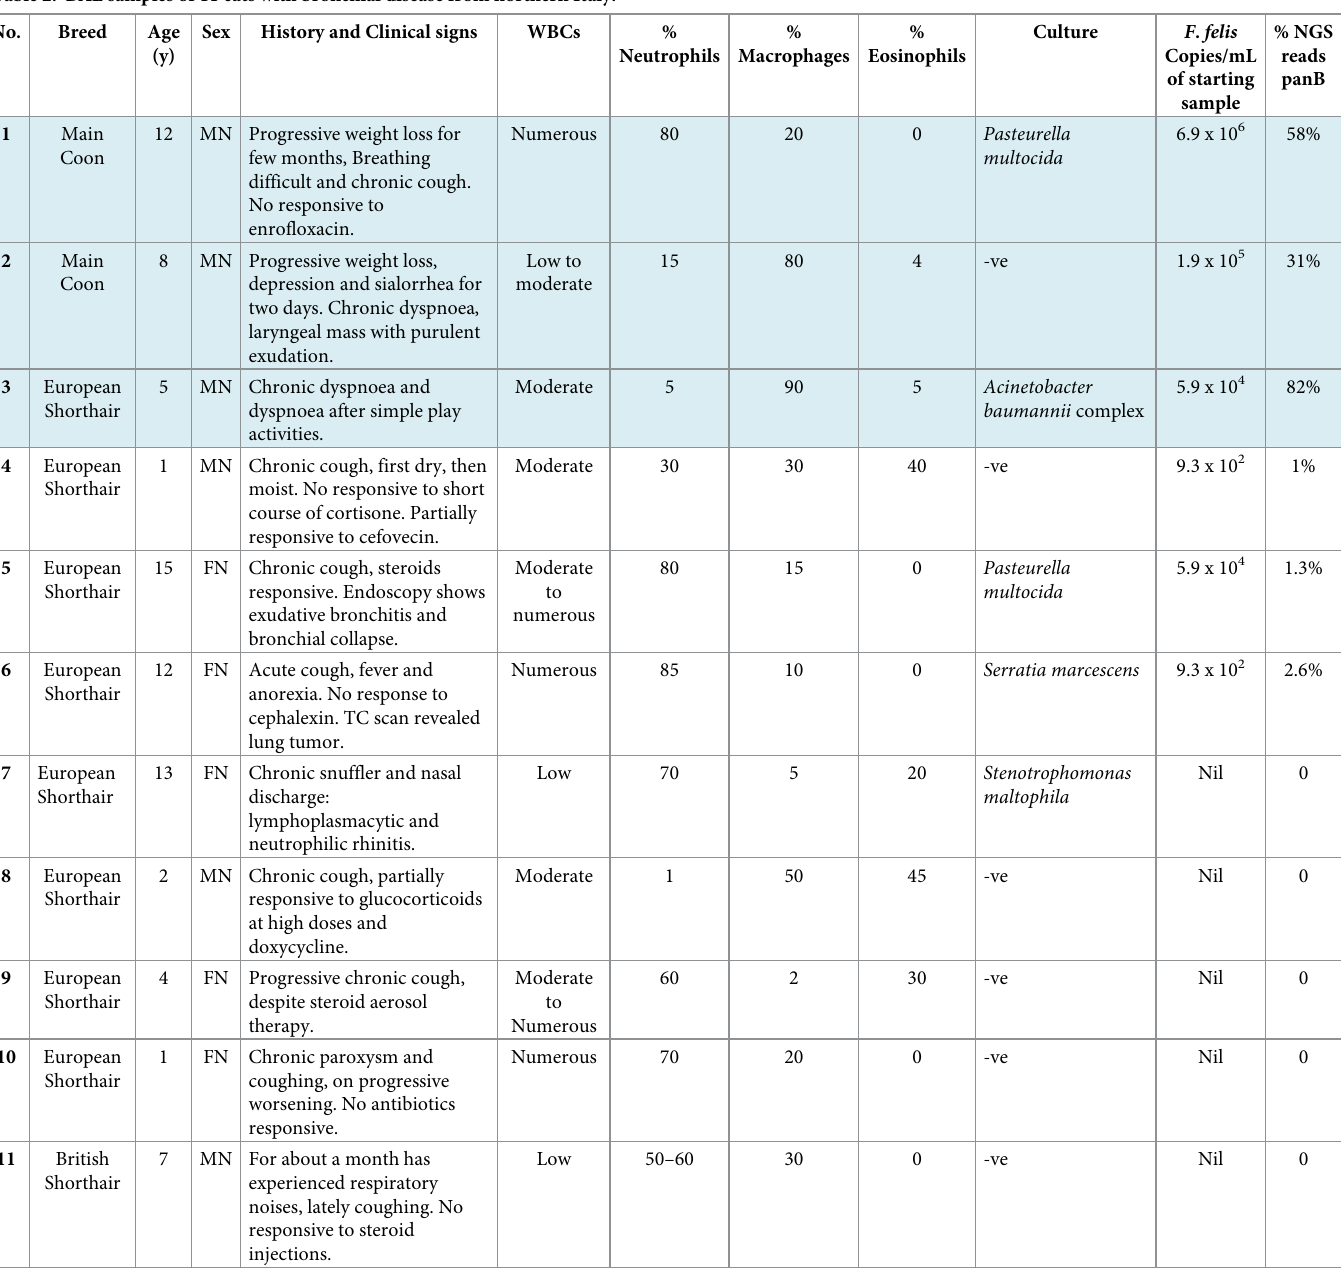
Table 2. BAL samples of 11 cats with bronchial disease from northern Italy.